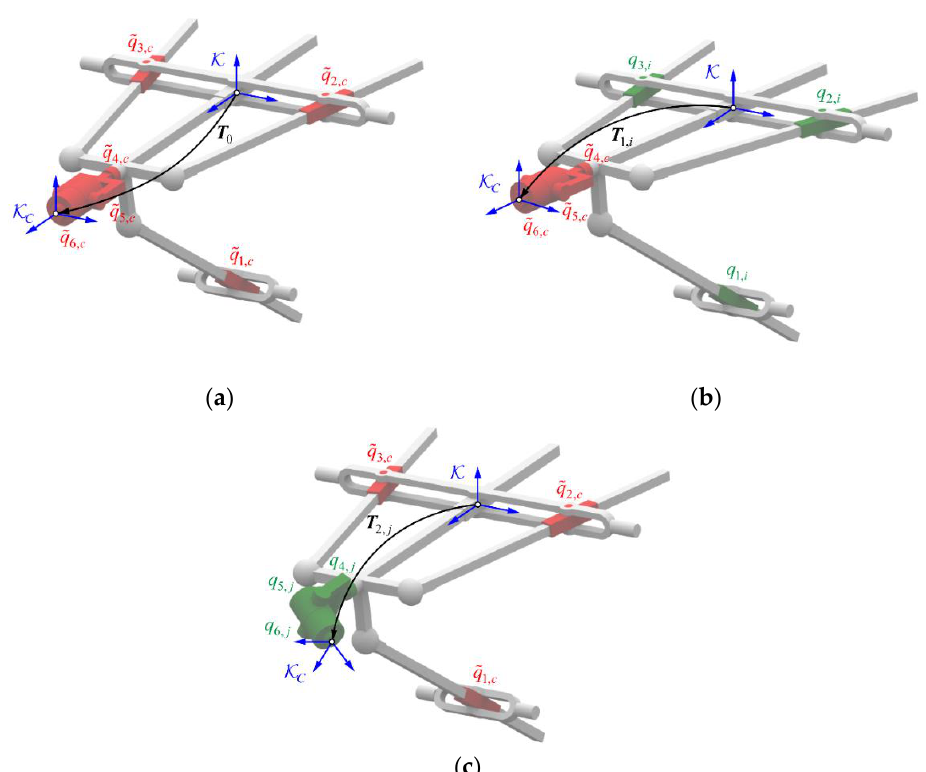
Figure 3. Schematic diagram of decomposition measurement: ( a ) Reference configuration; ( b ) Motion of the parallel mechanism; and ( c ) Motion of the wrist.